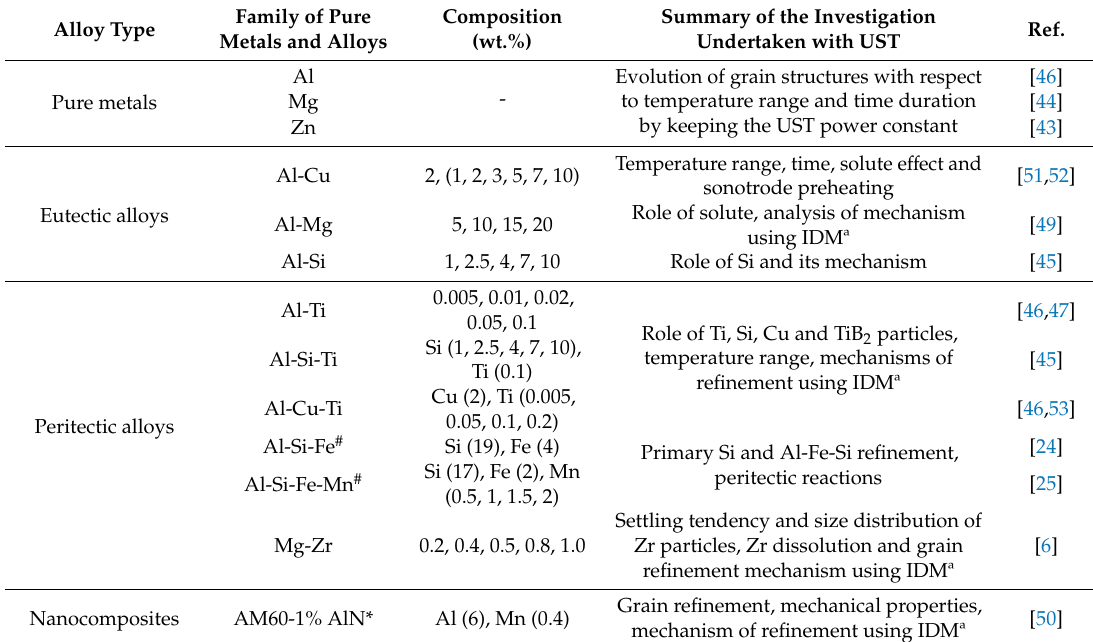
Table 1. List of the experiments undertaken at The University of Queensland (UQ) and allied research